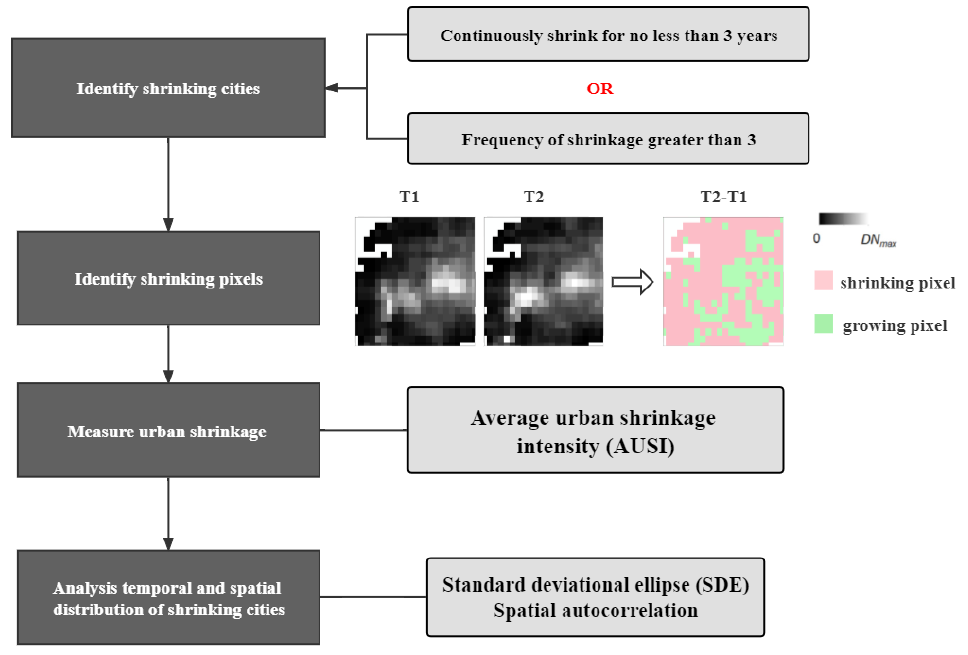
Figure 1. The flowchart for measuring urban shrinkage. Table 2. Different definitions of shrinking cities put forward by